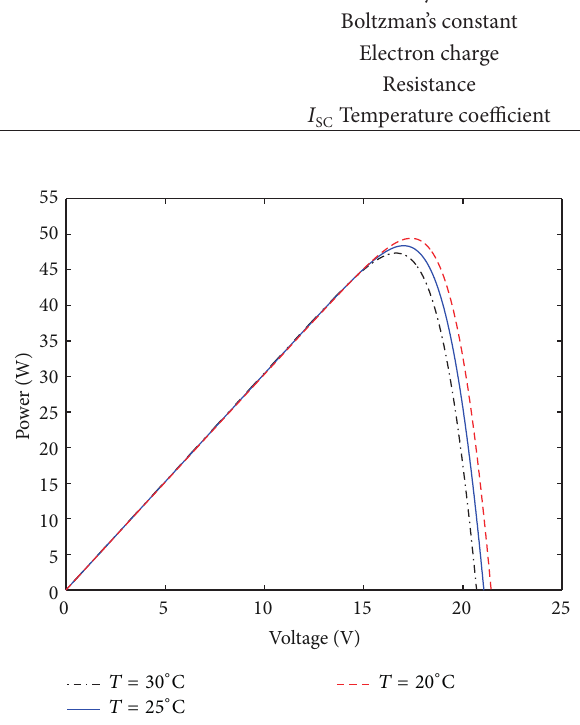
Figure 9: 𝑃 - 𝑉 chart of considered PV model for different tempera- tures (irradiation = 1000W / m 2